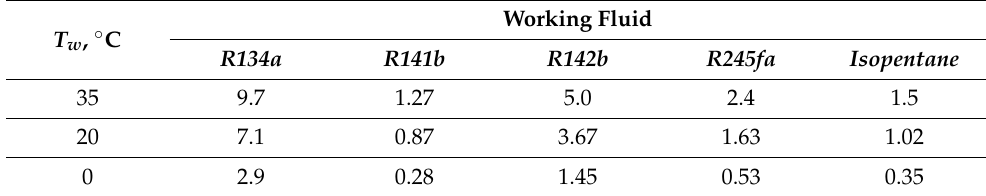
Table 6. Impact of outboard sea water temperature on working fluid condensation pressure. T w , ◦